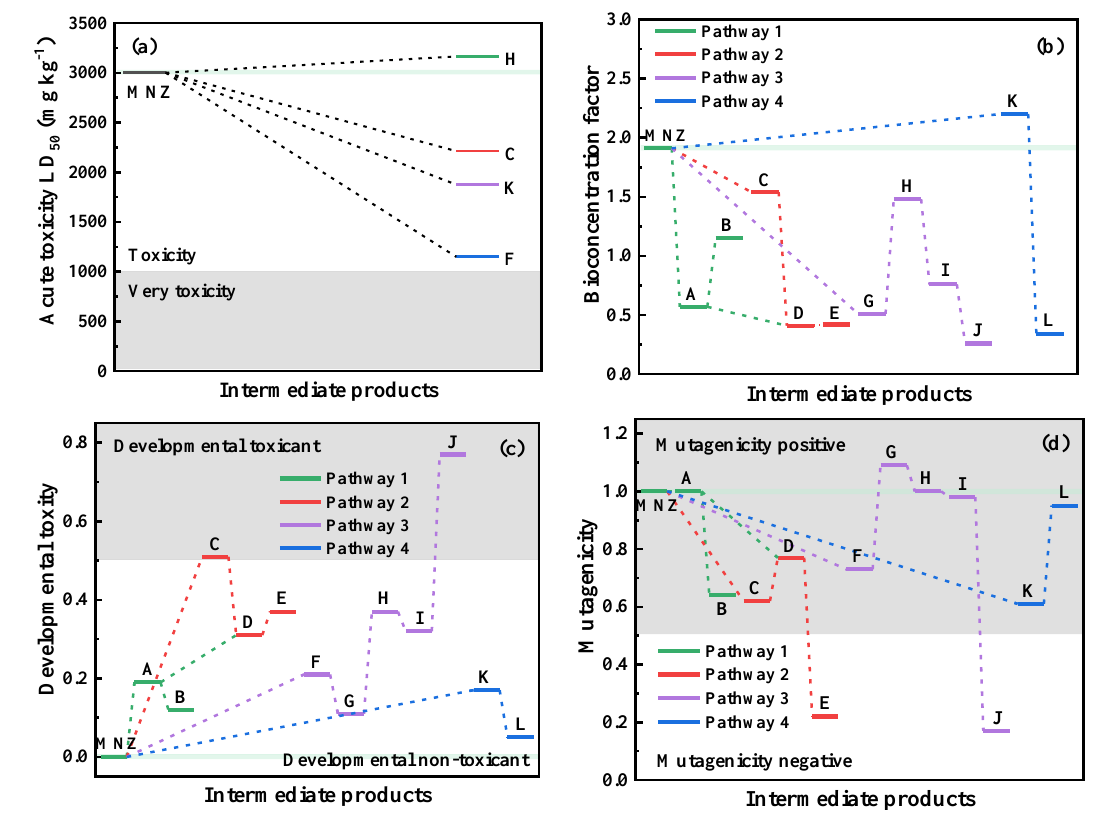
Figure 11. Toxicity assessment of metronidazole and its degradation intermediate products (met- ronidazole is abbreviated as MNZ): ( a ) acute toxicity LD 50 , ( b ) bioconcentration factor, ( c ) develop- mental toxicity and ( d ) mutagenicity. ( A – L ) intermediate products of metronidazole.